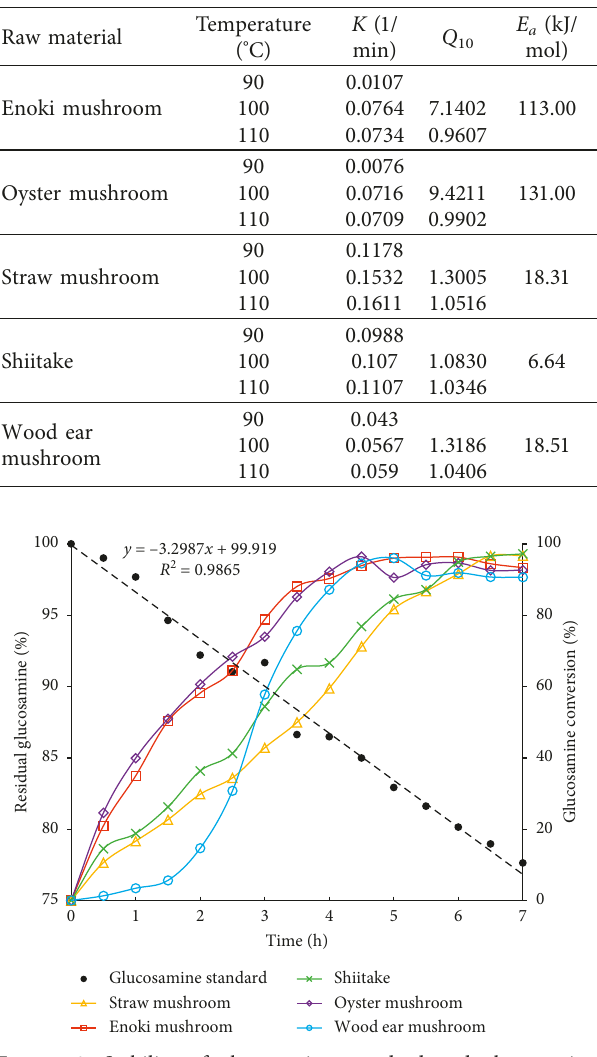
Figure 3: Stability of glucosamine standard and glucosamine conversion from five mushrooms under optimum hydrolysis conditions (100 ° C, 6M H 2 SO 4 ).